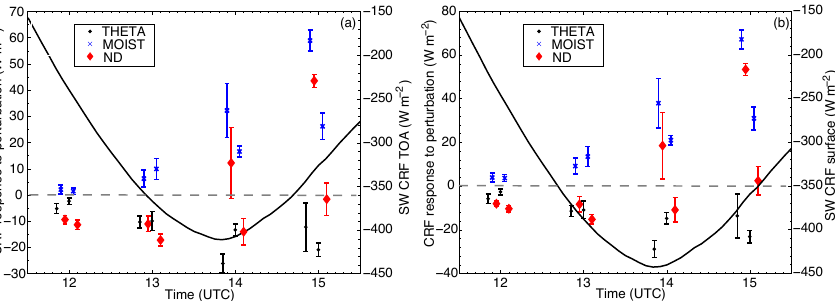
Fig. 13. Response of shortwave cloud radiative forcing (SW CRF), at (a) TOA and (b) the surface to perturbations in meteorological context and aerosol state, computed from the experimental simulations (left y-axis). Responses of SW CRF are shown as described in Fig. 11. For reference the black line shows the time series of base case SW CRF (right y-axis) and the grey dashed line indicates a zero response in SW